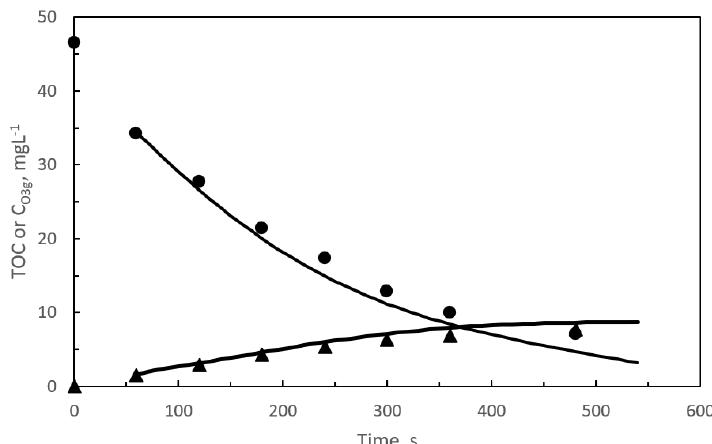
Figure 1. Single ozonation: Changes with time of calculated and experimental TOC ( • ), due to pharmaceuticals, and ozone gas concentration at the reactor outlet ( ▲ ) for the first reaction period. Symbols represent experimental data while curves are calculated results. Experimental conditions: pH = 7.5, gas flow rate: 35 L h − 1 , ozone mass rate: 5.83 mg min − 1 . SEMWW initial TOC: 10 mg L − 1 . Initial TOC due to pharmaceuticals: 46.5 mg L − 1 .